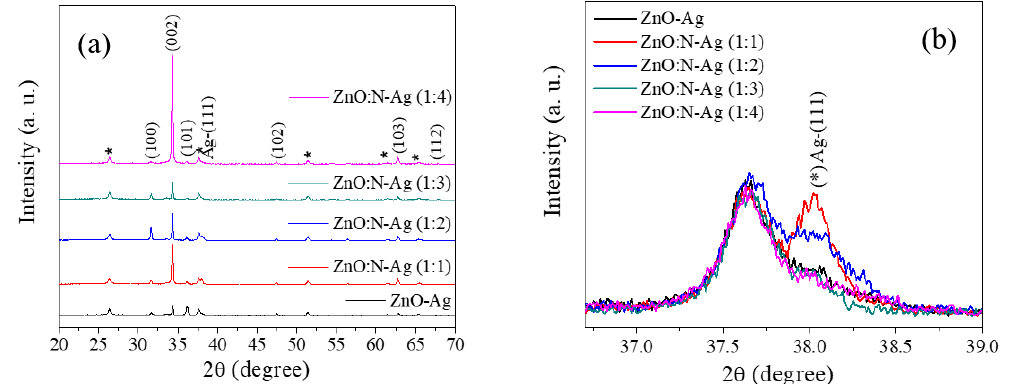
Figure 5. ( a ) XRD patterns of Ag-decorated undoped and ZnO:N NRs with different nitrogen contents in the seed layer; ( b ) enlarged view of the FTO peak shown in Figure 5a.